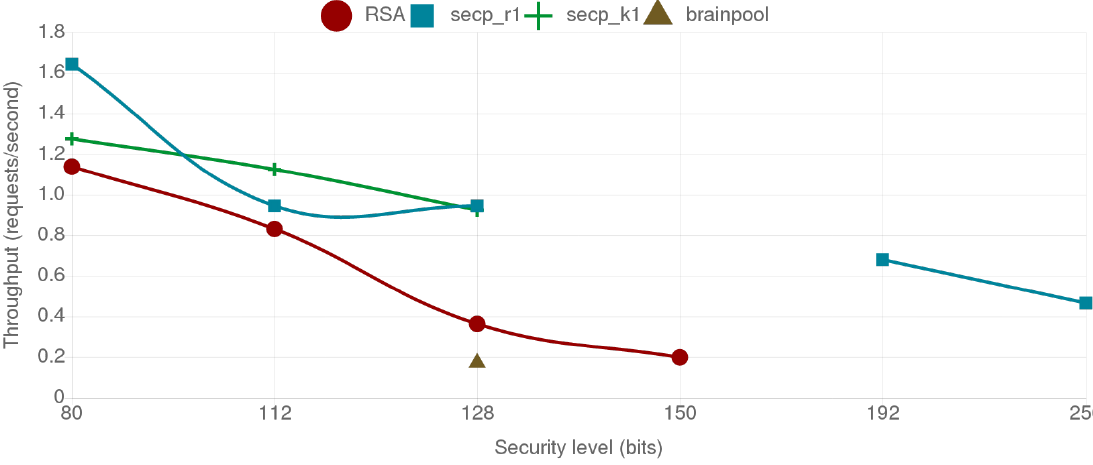
Figure 8. Throughput values in requests per second between the mist end-device and the fog